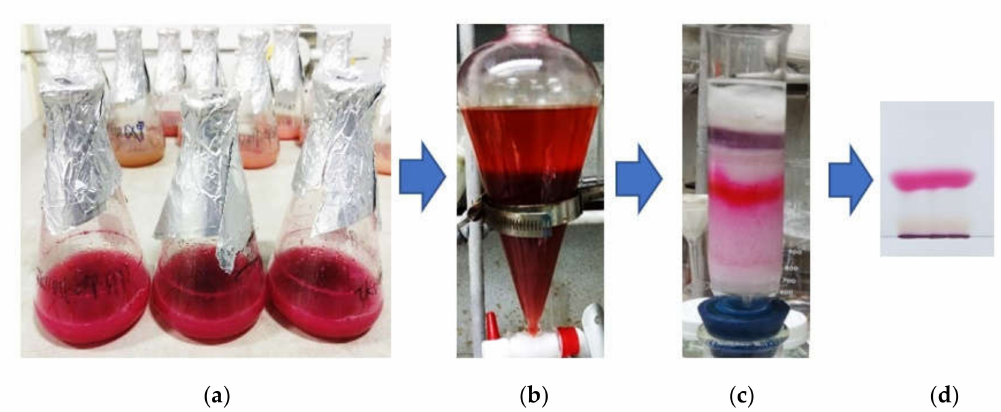
Figure 5. The process of PG purification. The liquid culture medium fermented by S. marcescens TNU01 under optimal condition ( a ) was centrifuged to obtain the supernatant containing PG, which was primarily extracted by ethyl acetate ( b ). The crude PG containing in the ethyl acetate layer was next separated on a silica gel column ( c ) and finally, isolated as a pure compound by TLC separation ( d ).